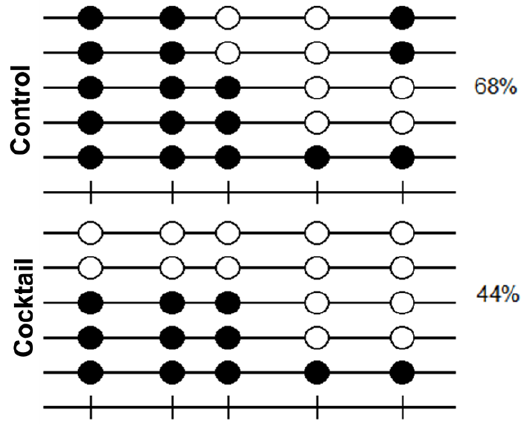
Figure 4. DNA methylation profile of the OCT4 promoter in human adult dermal fibroblast cells treated with 5AZ, VPA, and a cocktail of small molecules. Results were obtained from five different subcloned 221-bp PCR product for each group. Open and closed circles indicate unmethylated and methylated CpGs, respectively. Cocktail contains 1 mM VPA, 1 µM 5AZ, 5 µM CHIR99021, and 0.5 µM A83-01. Each row represents data from a single DNA molecule. The number shown in each lollipop methylation diagram indicates the percentage of methylated CpG sites.